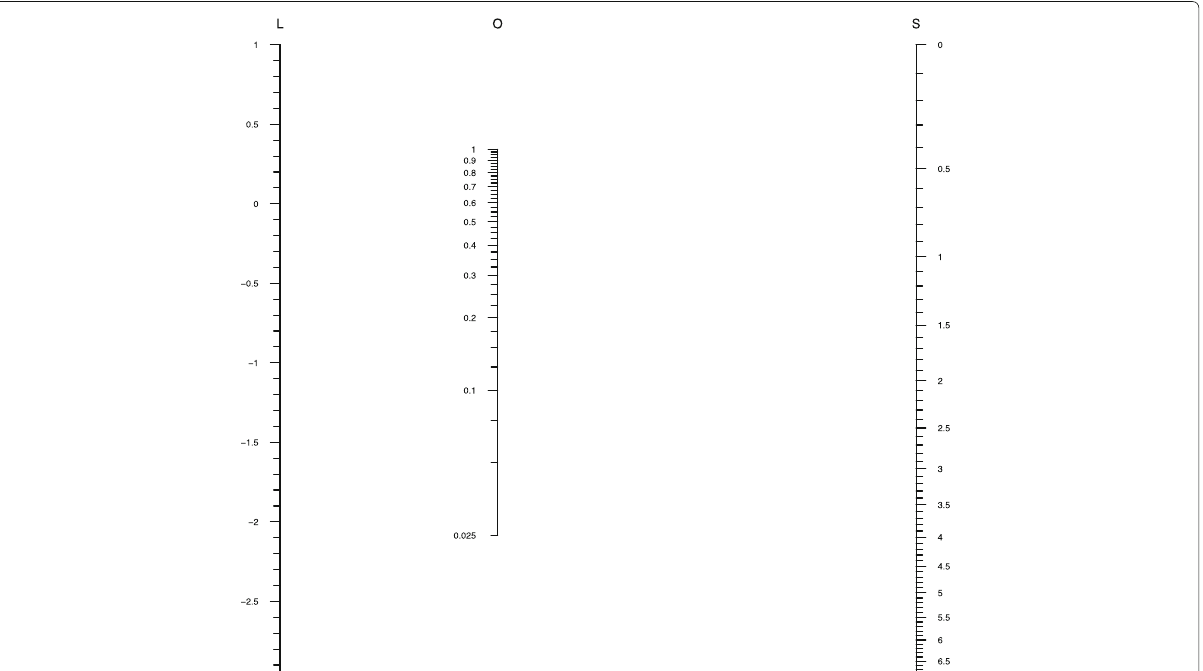
(cid:9) { lp p ( x i ) p exp